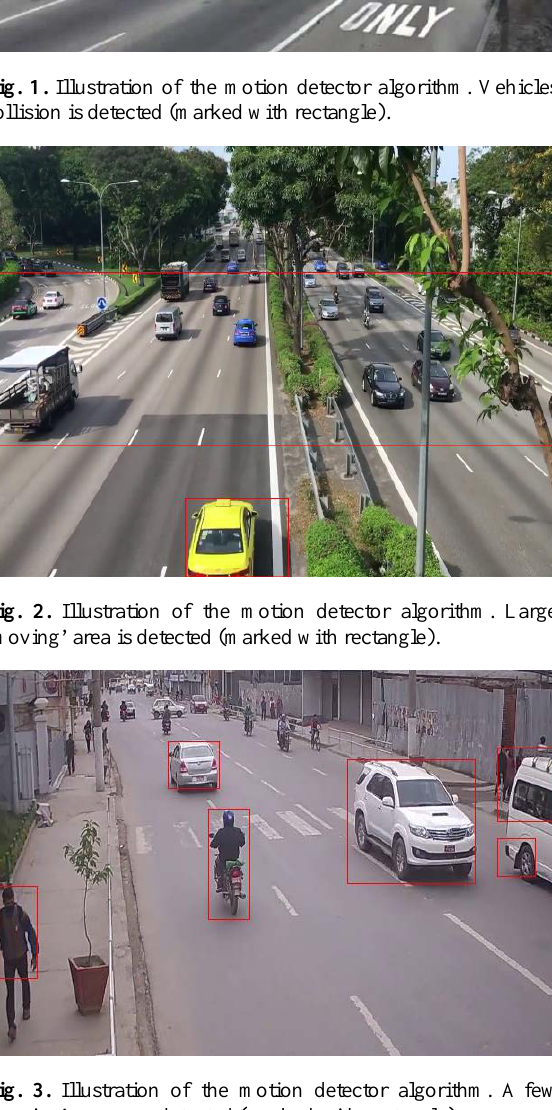
Fig. 3. Illustration of the motion detector algorithm. A few ‘moving’ areas are detected (marked with